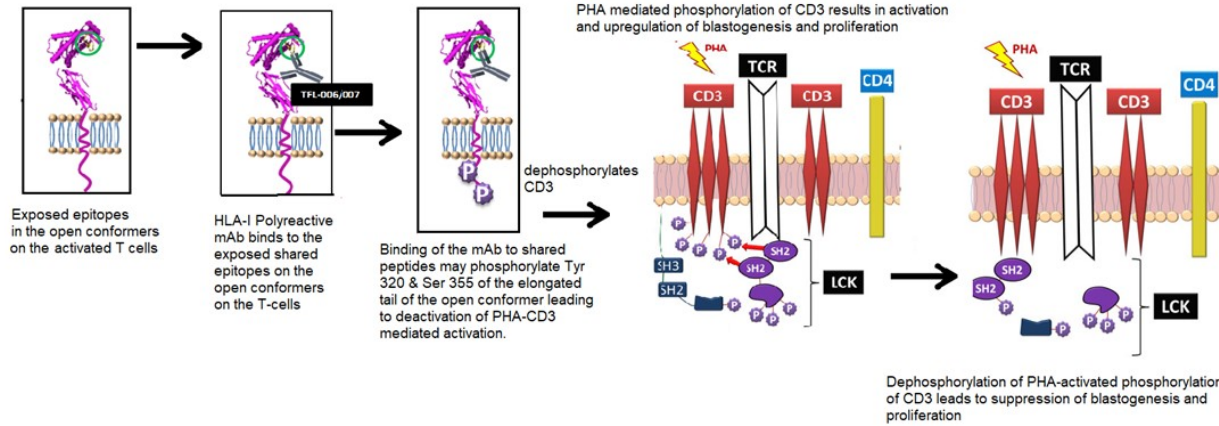
Figure 9. A model illustrating the possible mechanism underlying phytohemagglutinin (PHA) activation of T-cells and the suppression of activated T-cells mediated by HLA-I polyreactive mAbs (TFL-006 and TLF-007) and possibly by IVIg. The model is based on a model proposed by Mustelin, Vang, and Bottini [77] for T-cell activation. The CD3/T-cell receptor (TCR)/CD4 structure on the lipid raft (pink zone) of the bi-layered lipid membrane on the non-phosphorylated, non-activated CD4+ T-cells is illustrated. The lymphocyte-specific protein, tyrosine kinase (LCK), induced phosphorylation of tyrosine-based activation in the cytoplasmic domain of CD3, which led to the activation of transcription factors and the transcription of cell surface molecules such as interleukin (IL)-2R α and open conformers of HLA class I. SH-1, SH-2, and SH-3 represent family members of Src homology; they are involved in mediating the cytoplasmic domain of CD3. Further activation of the tyrosyl-phosphorylated motifs and then interaction with SH-1 domains within the protein kinase LCK led to further signaling function [77]. Importantly, the exposure of shared amino acid sequences of all the HLA open conformers is indicated by a blue circle. It is this site that is recognized by TFL-006 and TFL-007. Possible interactions and consequences of recognition of the shared peptide sequences by the HLA-I polyreactive IgG mAbs are illustrated in three steps: first, the exposure of the shared peptide sequence on the open conformer; secondly, recognition of the shared epitopes on the open conformer by the mAbs; thirdly, possible phosphorylation of the elongated cytoplasmic tail of open conformers. That elongation resulted in the exposure of cryptic tyrosine (Tyr320) and serine (Ser355) residues in the cytoplasmic tail. It might have been the binding of the mAbs to the shared peptide sequences that initiated the phosphorylation, leading to signal transduction. A final step involved initiation of dephosphorylation of the cytoplasmic domain of CD3, resulting in arrest of activation or suppression. That seemed plausible, as the phosphorylation was known to be reversible.